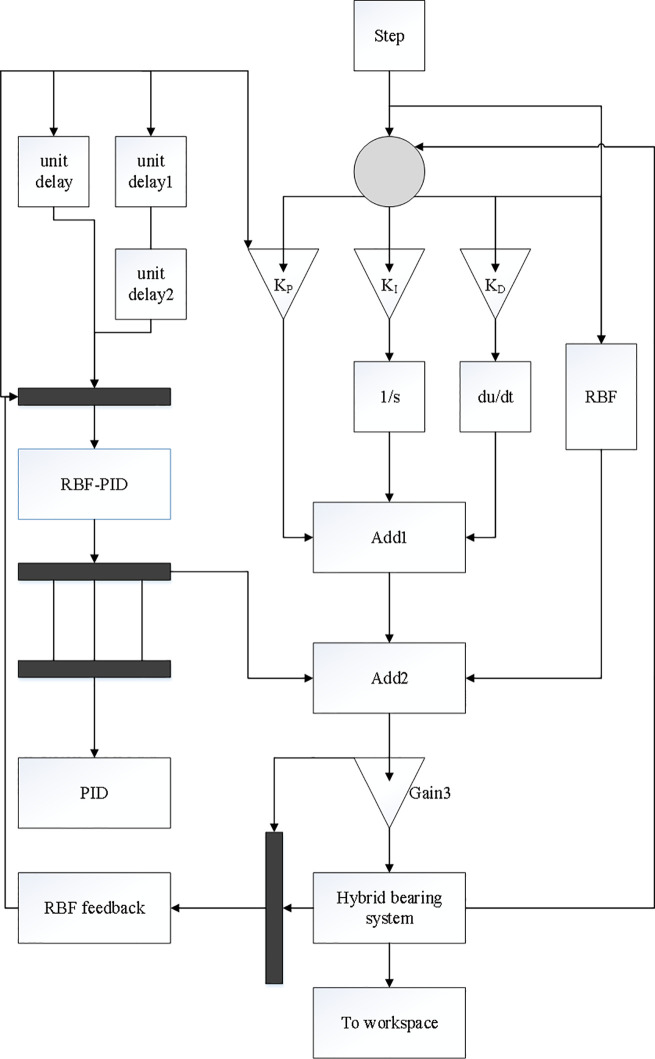
Simulation block diagram of hybrid bearing system control based on the RBF neural network.